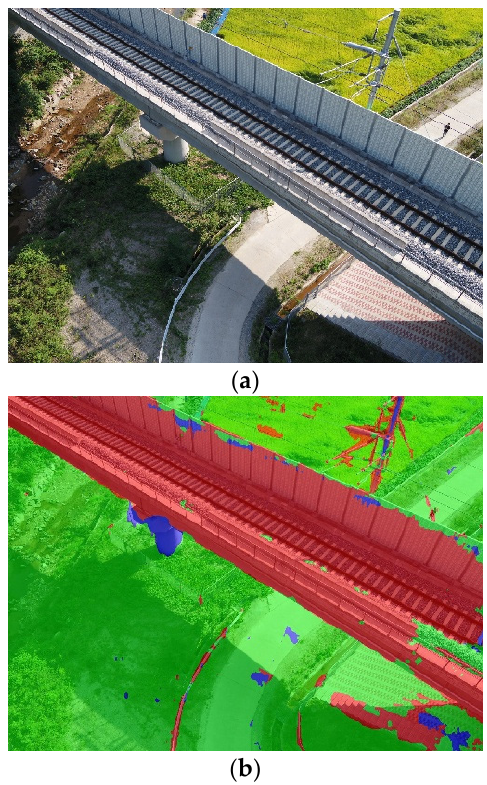
Figure 12. ( a ) Image data; ( b ) predicted label data. Table 5. Semantic segmentation results.